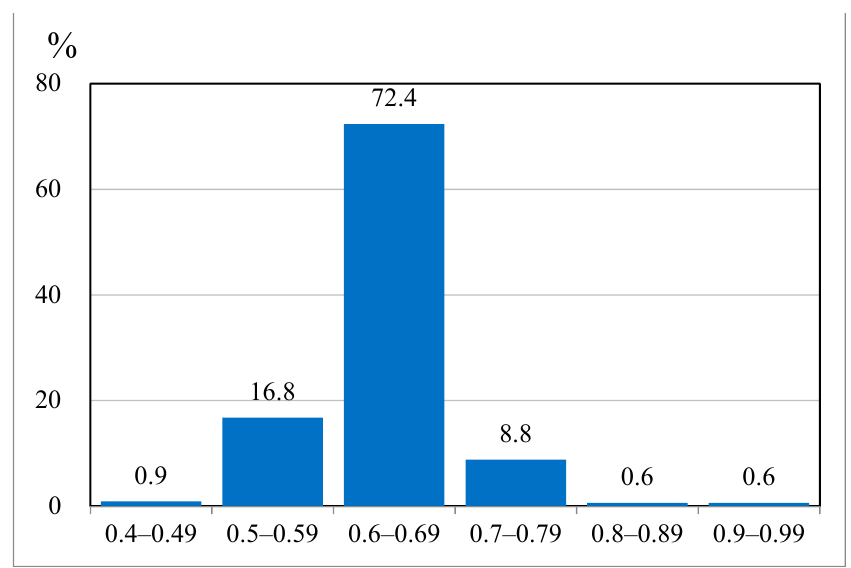
Figure 6. Distribution of group technical efficiency (GTE) scores of Overwinter Harvest.